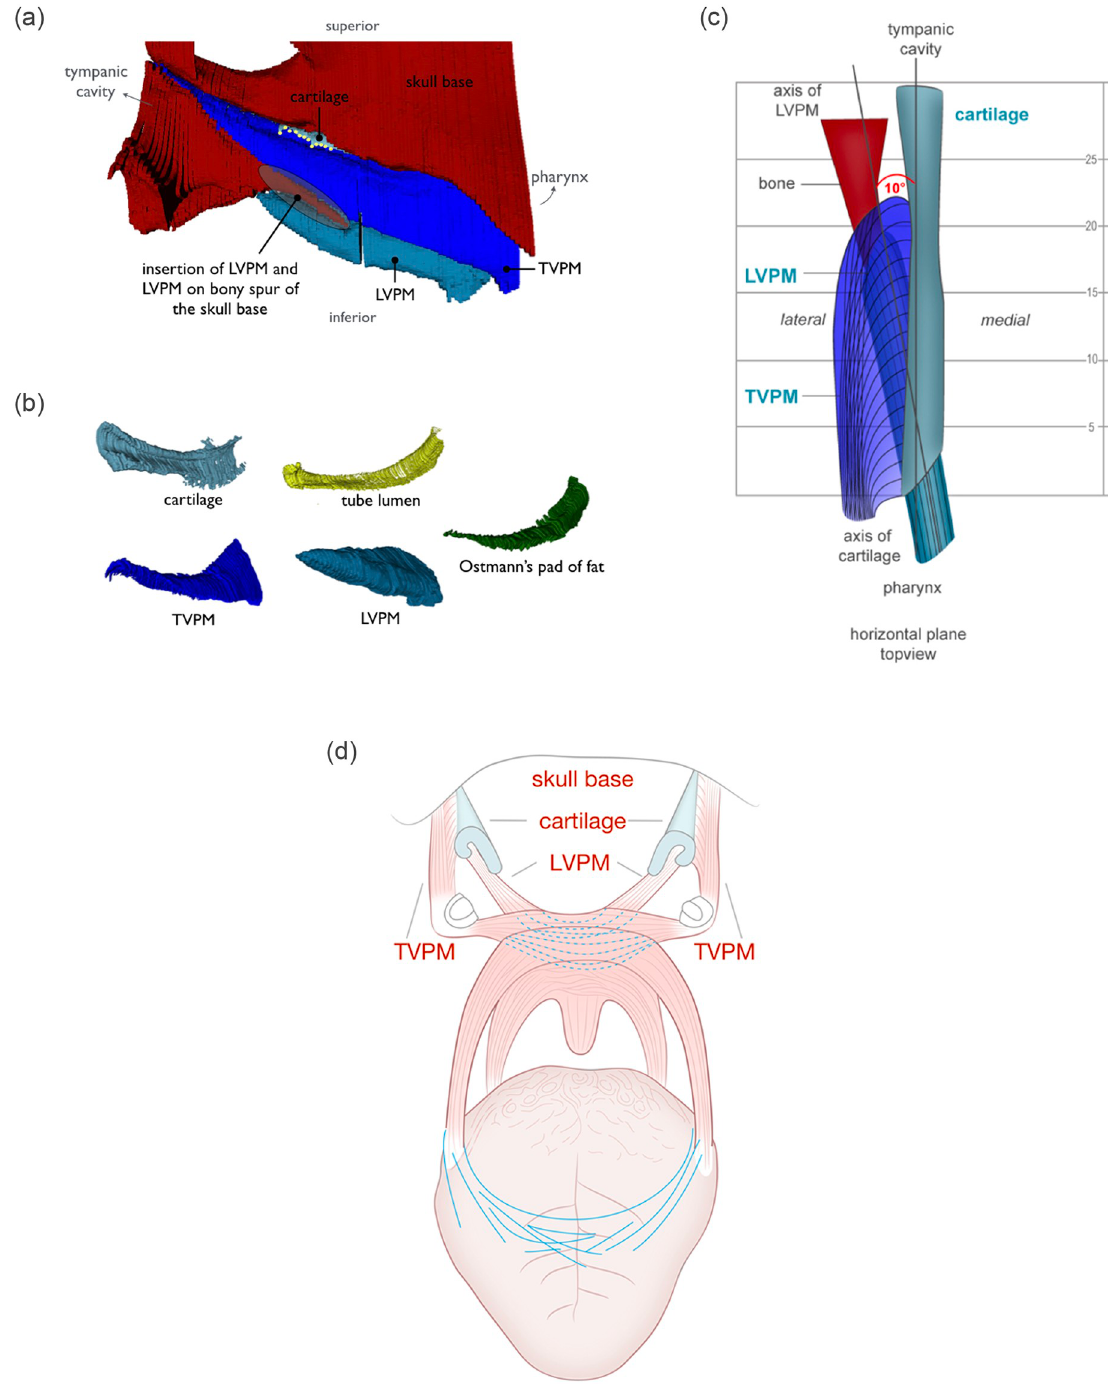
Fig 3. Compound model of the ET from lateral side (a) and isolated compartments (b) in correlation to the bony skull base (red). From left: cartilage (petrol), ET lumen (yellow), TVPM (dark blue), LVPM (light blue), OFP (green). (c) Compound model of the ET above, skull base removed. Bony process of the skull base as origin of the LVPM in red and other compartments in same colour as Fig 3. Compare to coronal projection in Fig 7 illustrating spiral rotation of tubular cartilage. (d) Topographic schematic of the major muscular functional components involved in tube opening. The loop of the LVPM forms a functional muscular circuit. The TVPM inserts in the lateral part on both sides of the tubal cartilage.